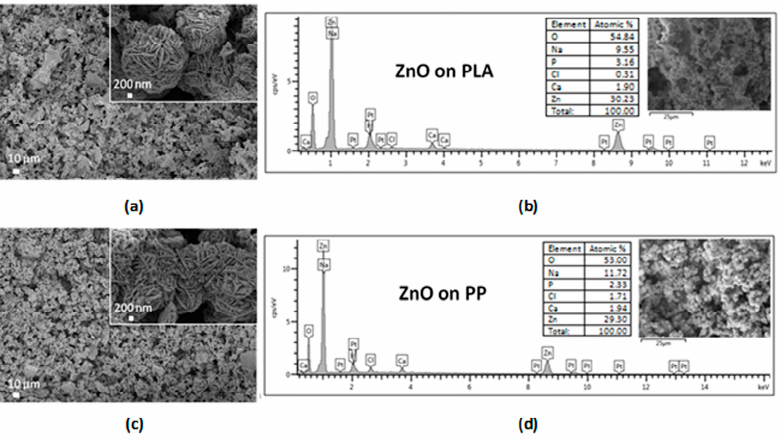
Figure 10. ZnO-coated PLA and PP supports soaked in SBF for 14 days: ( a , c ) FESEM images and ( b , d ) EDX spectra.